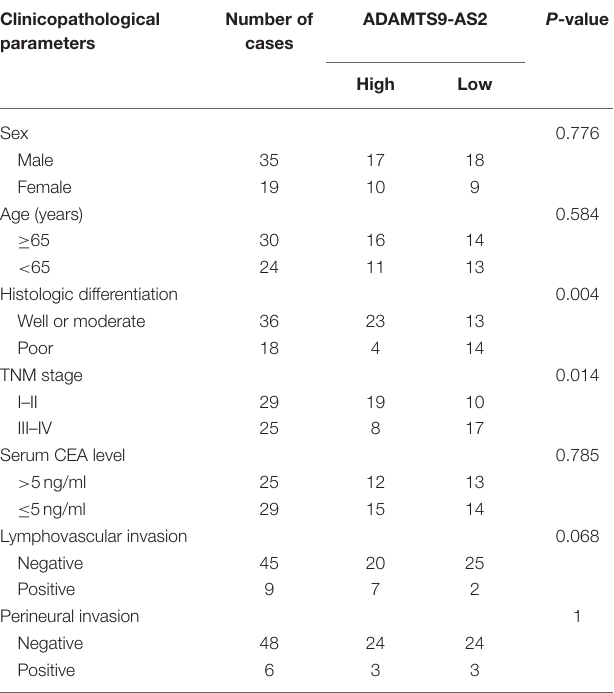
TABLE 1 | Correlation between ADAMTS-AS2 expression levels and the clinicopathological parameters of 54 GC patients. Clinicopathological Number of parameters